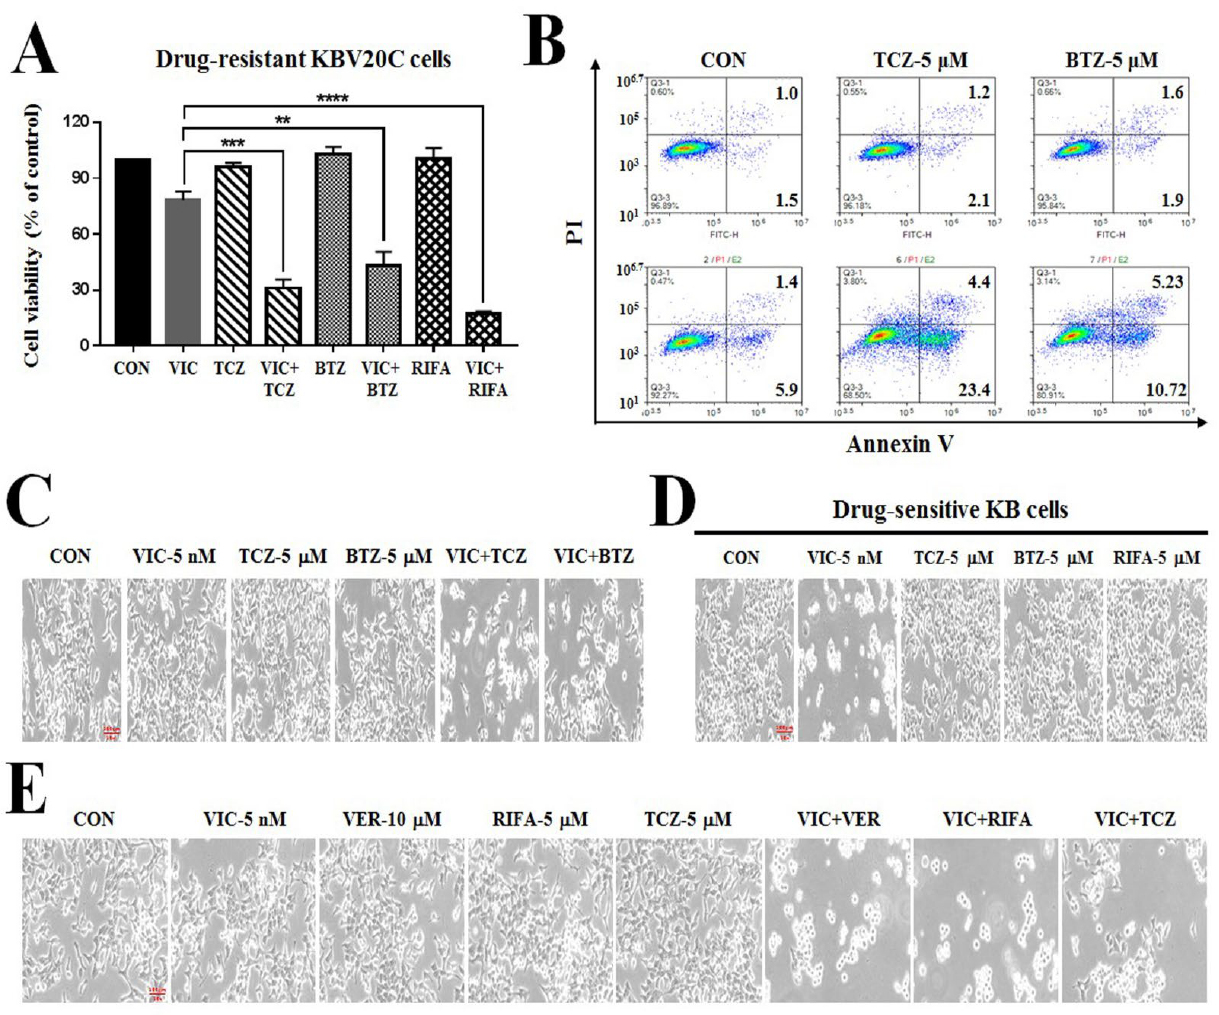
Figure 1. Both TCZ and BTZ increase VIC cytotoxicity in P-gp-overexpressing drug-resistant KBV20C cancer cells. ( A ) Drug-resistant KBV20C cells were plated on 96-well plates and grown to 30–40% confluence. The cells were then treated for 48 h with 5 nM VIC, 5 µ M TCZ, 5 µ M BTZ, 5 µ M rifabutin (RIFA), 5 nM VIC with 5 µ M TCZ (VIC + TCZ), 5 nM VIC with 5 µ M BTZ (VIC + BTZ), 5 nM VIC with 5 µ M rifabutin (VIC + RIFA), or 0.1% DMSO (CON). Cell viability assay was performed as described in “Materials and methods”. The data are presented as the mean ± S.D. of at least two experiments repeated in triplicate experiments. Data are presented as mean ± SD. ** p < 0.01, *** p < 0.001, or **** p < 0.0001 was considered be statistically significant. ( B ) KBV20C cells were treated with 5 nM VIC, the indicated µ M concentrations of TCZ or BTZ alone, or in combination with 5 nM VIC, or 0.1% DMSO (CON). After 24 h, annexin V analyses were performed as described in Materials and Methods. ( C ) KBV20C were treated with 5 nM VIC, 5 µ M TCZ, 5 µ M BTZ, 5 nM VIC with 5 µ M TCZ (VIC + TCZ), 5 nM VIC with 5 µ M BTZ (VIC + BTZ), or 0.1% DMSO (CON). After one day, all cells were observed using an inverted microscope at × 100 magnification. ( D ) Drug-sensitive parent KB cells were treated with 5 nM VIC, 5 µ M TCZ, 5 µ M BTZ, 5 µ M rifabutin (RIFA), or 0.1% DMSO (CON). After one day, all cells were observed using an inverted microscope at × 100 magnification. ( E ) KBV20C were treated with 5 nM VIC, 10 µ M verapamil (VER), 5 µ M TCZ, 5 µ M BTZ, 5 nM VIC with 10 µ M verapamil (VIC + VER), 5 nM VIC with 5 µ M TCZ (VIC + TCZ), 5 nM VIC with 5 µ M rifabutin (VIC + RIFA), or 0.1% DMSO (CON). After one day, all cells were observed using an inverted microscope at × 100